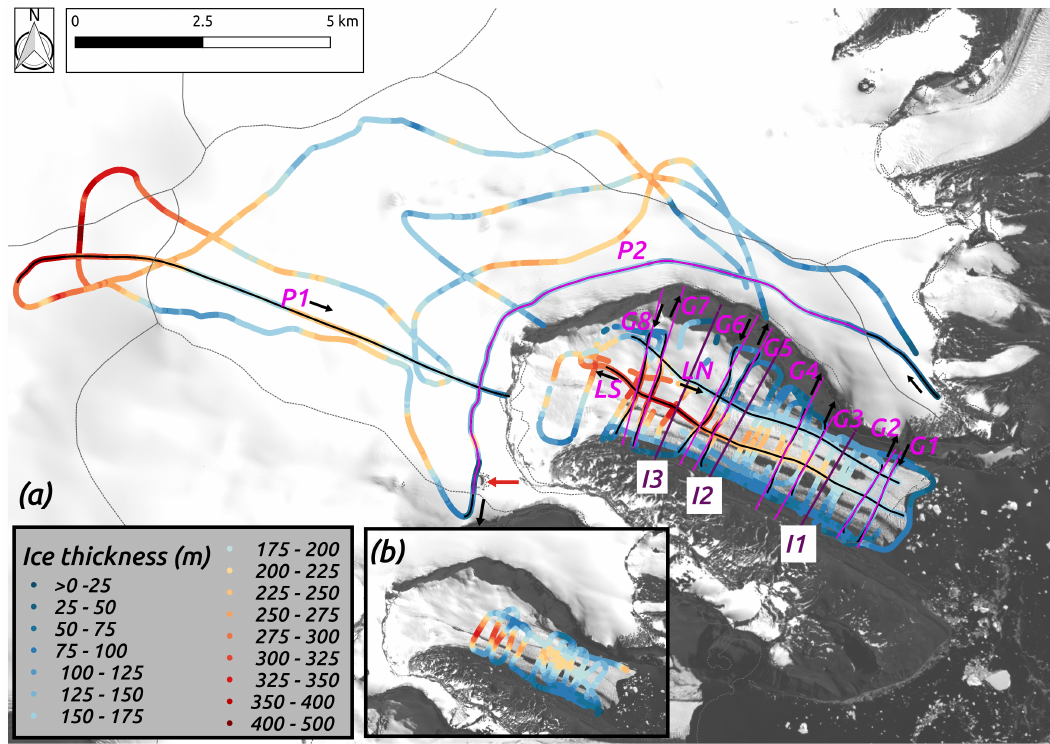
Figure 2. ( a , b ) Ice thickness measurements from the GPR campaigns 2018 ( a ) and 2017 ( b ). Profile lines (G1–G8, LN/LS, P1/P2) used for the radargrams are shown in black with arrows indicating the flight direction. In the foreground of the GPR profiles are the flux gates G1–G8 and P2 with a maximum overlap with the in situ GPR data (bright purple lines) and at glacier areas with purely interpolated data (I1–I3, dark purple lines). The red arrow indicates a bedrock outcrop within the ice cap. Background image: Landsat-8 (20 February 2017, courtesy of the U.S. Geological